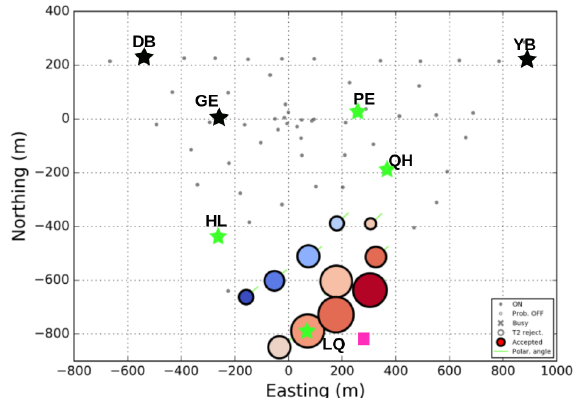
Figure 5. Map indicating the electric field of an event mea- sured by the CODALEMA antennas and the EXTASIS antennas. Coloured circles and grey dots represent the CODALEMA an- tennas, while the stars depict the low-frequency antennas. The size of the circles indicate the amplitude of the signal and the colour indicates the arrival time of the signal. A black star in- dicates no low-frequency signal, and a green star indicates the measurement of a low-frequency transient.